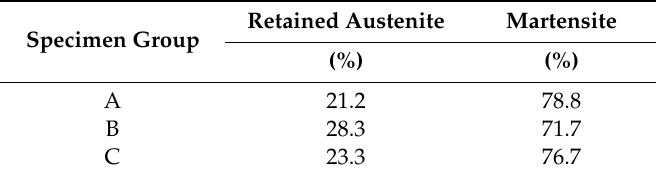
Figure 10. XRD results of SLM AISI 420 specimens built in various directions. Table 4. Phase content in SLM AISI 420 specimens with various build directions.